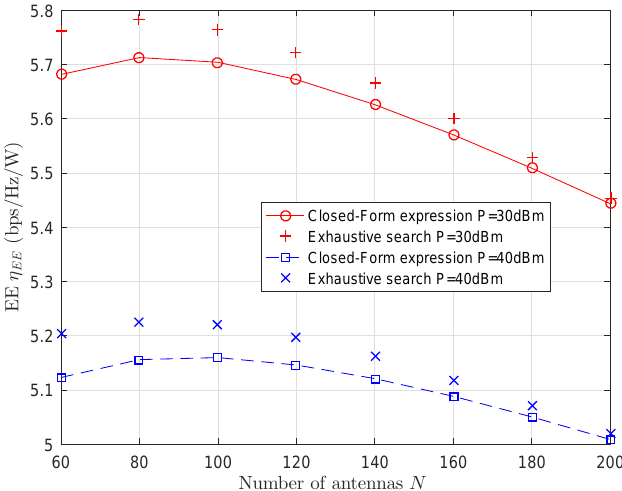
Figure 3. Comparison of power allocation schemes between closed-form expressions and the exhaustive